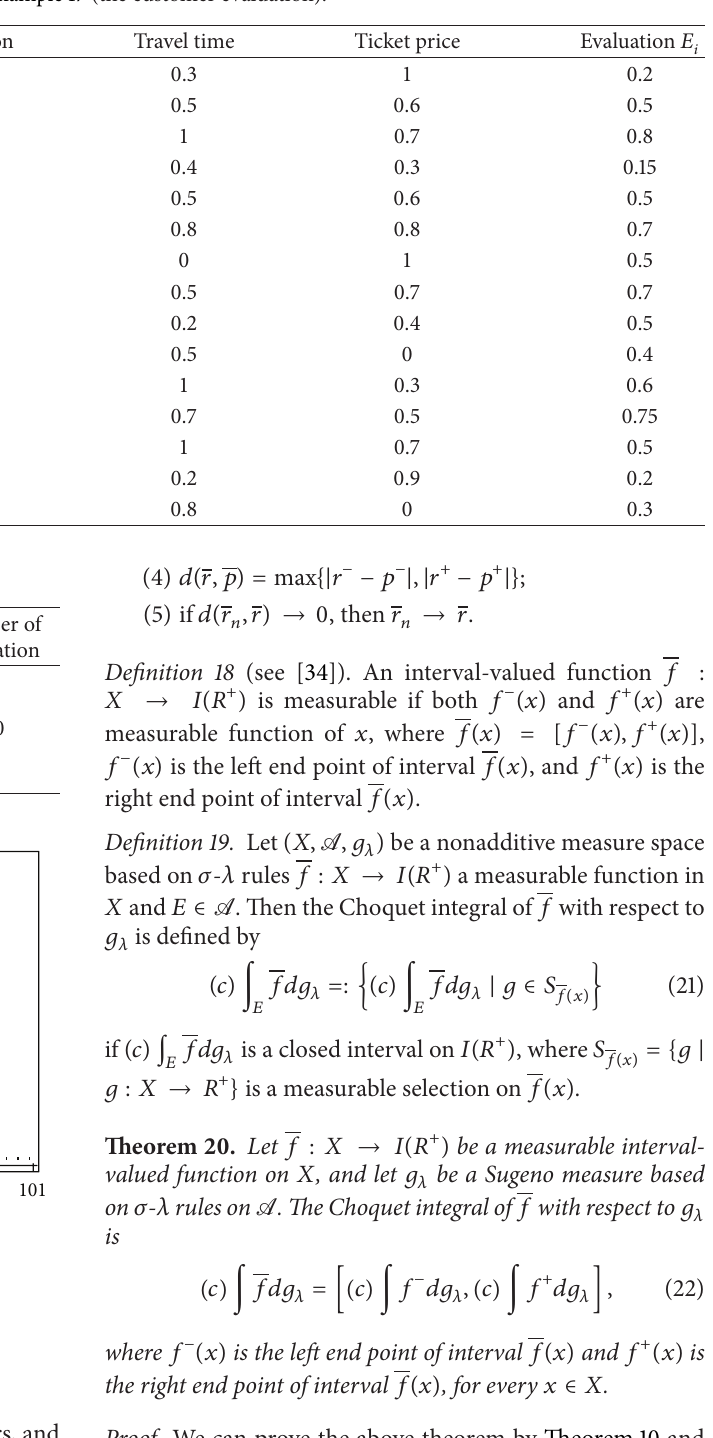
𝐼(𝑅 + ) = {𝑟 : [𝑟 − , 𝑟 + ] ⊂ 𝑅 + } is the set of interval numbers, and 𝐹(𝑋) is the set of all interval numbers